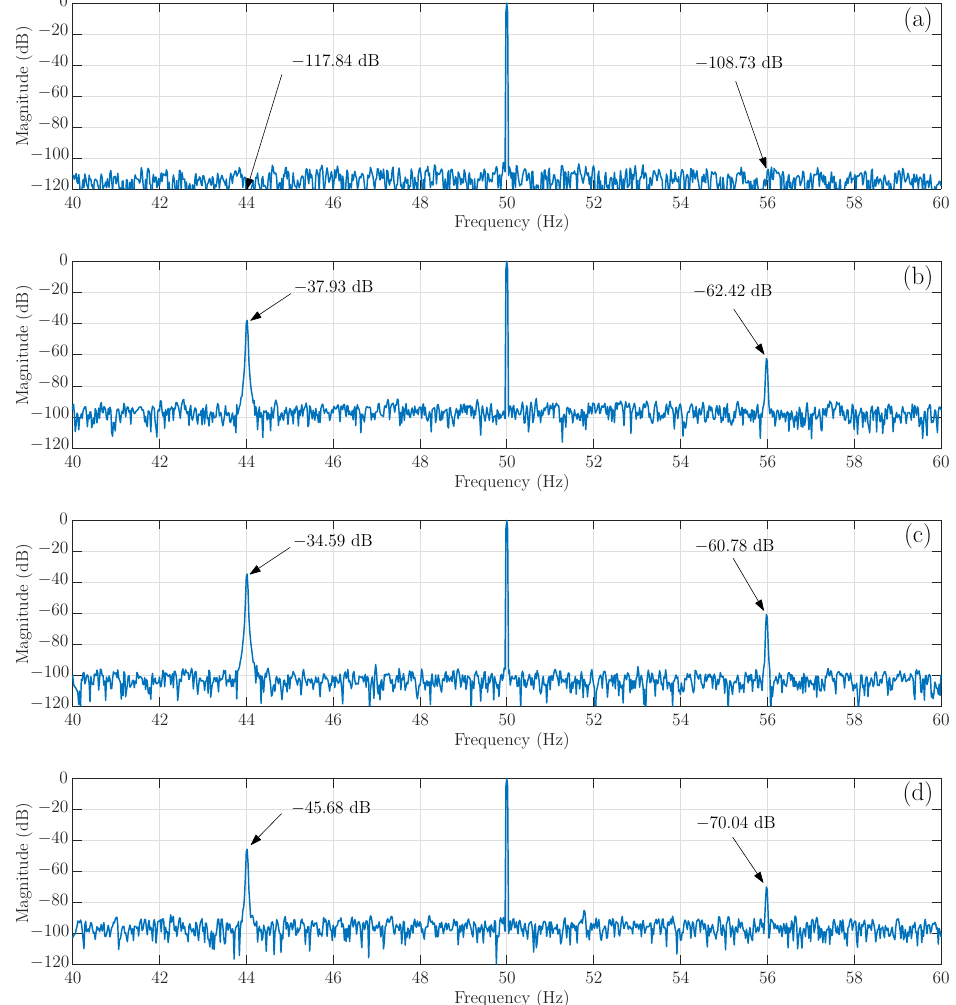
Figure 17. Spectra of the stator current obtained in the simulated tests of the motor of Appendix A with the following cage faults: ( a ) without fault, ( b ) one broken bar, ( c ) two consecutive broken bars (broken bars b 2 , b 3 ) and ( d ) two non-consecutive broken bars (broken bars b 2 , b 6 ). The main fault harmonics have been marked with text arrows, indicating their